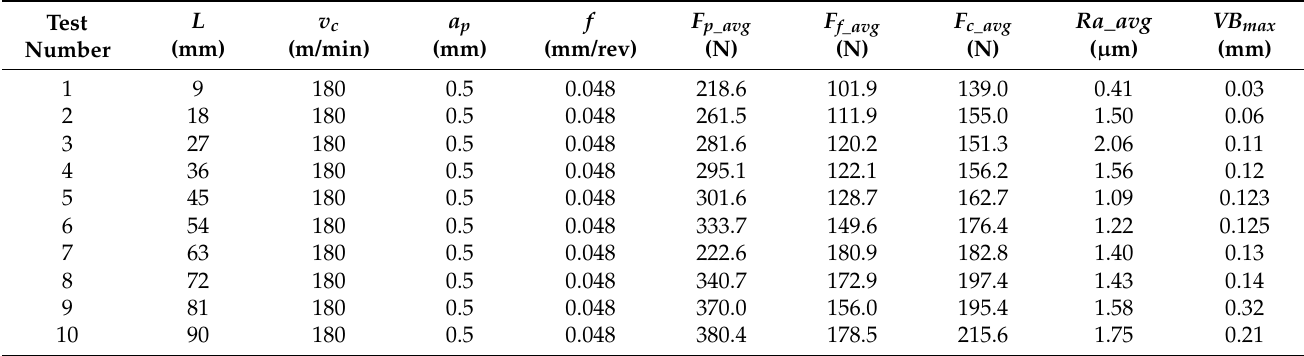
Table 6. Summary of the results of measurements of the cutting edge wear, the values of the components of the total cutting force, and the Ra arithmetic mean value of surface roughness for the case of turning with a speed vc = 180 m/min.